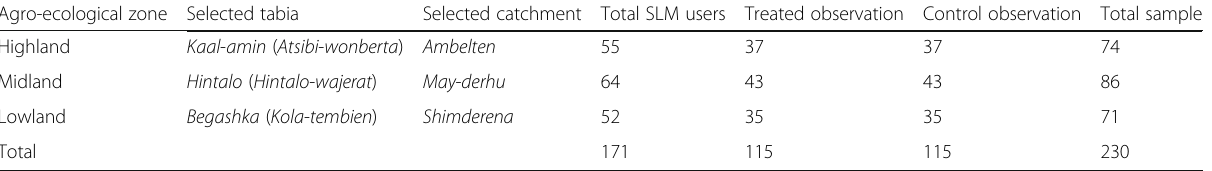
Table 1 Distribution of respondents by study tabia and catchment (districts in parentheses) Agro-ecological zone Selected